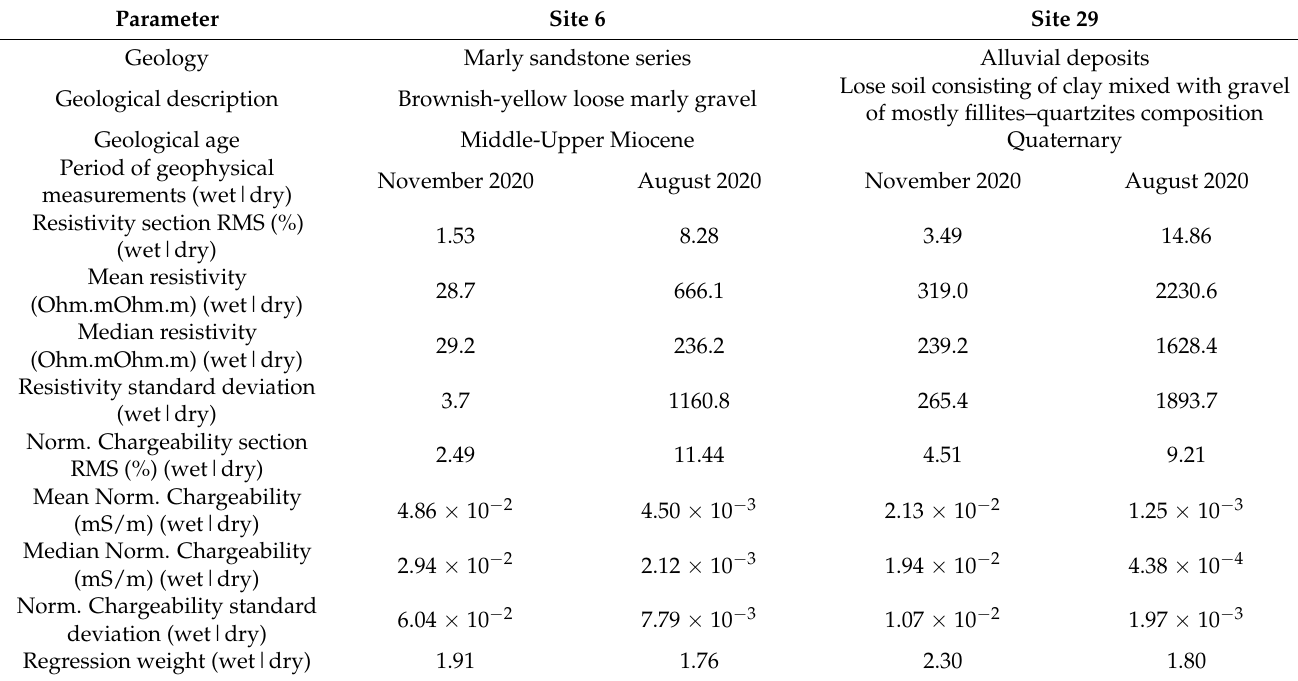
Figure A2. Geological formations in the arable fields of the study area. Photos are from the sam- pling campaign.